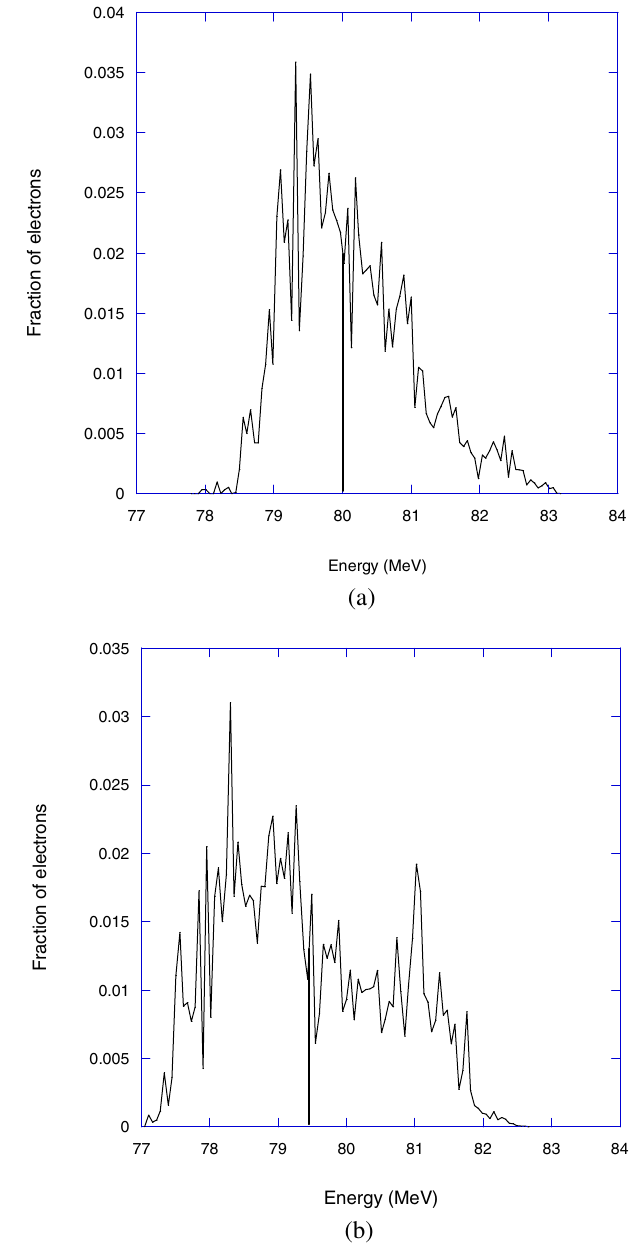
FIG. 9. (Color) Spent beam distribution from (a) the uniform wiggler, and (b) the two-stage